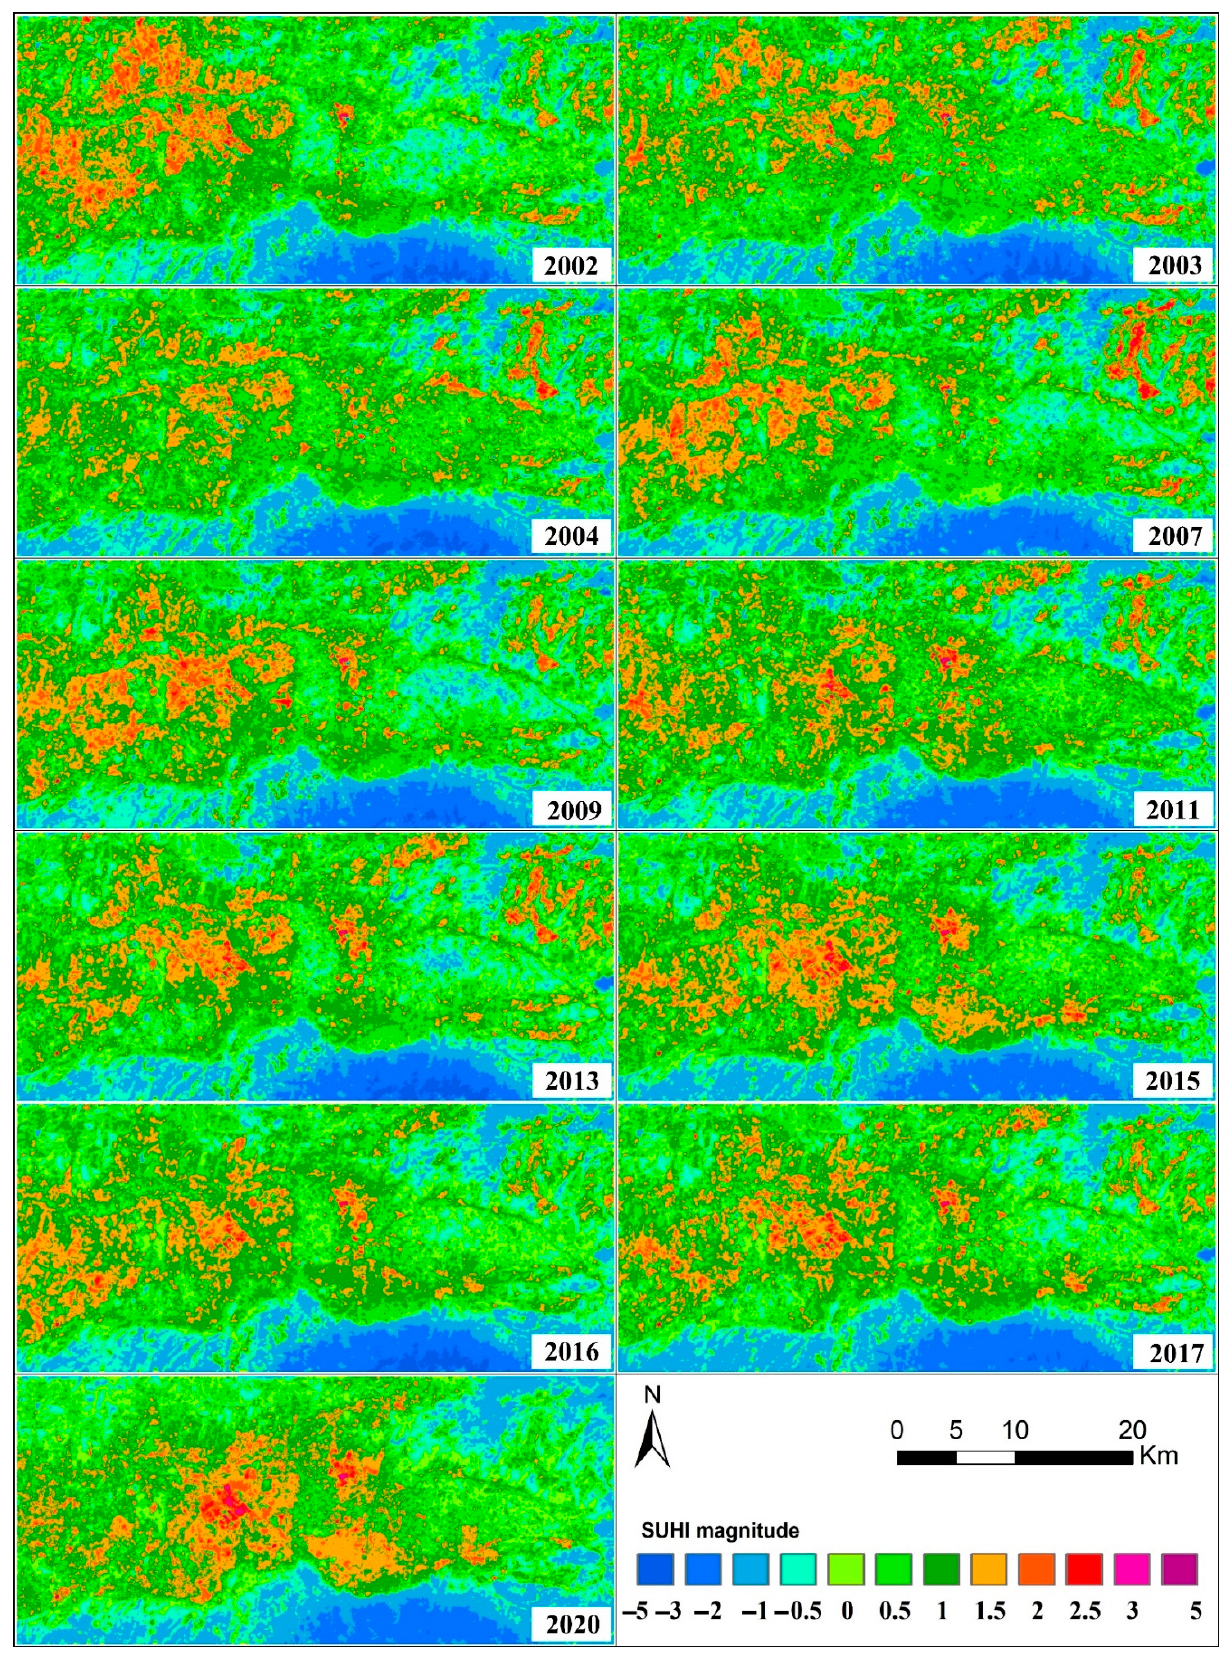
Figure 8. The UHI maps of the study area for the years: 2002, 2003, 2004, 2007, 2009, 2011, 2013, 2015, 2016, 2017 and 2020.